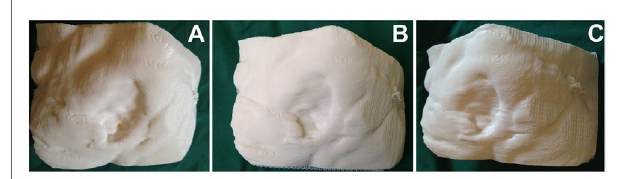
FigUre 3 | Three-dimensional (3D) printed model of the sacral defect shown in Figure 2, produced using a 3D printer (cube 2 printer, 3D systems, rock hill, sc, Usa) (a–c: three dimensional rotating views)